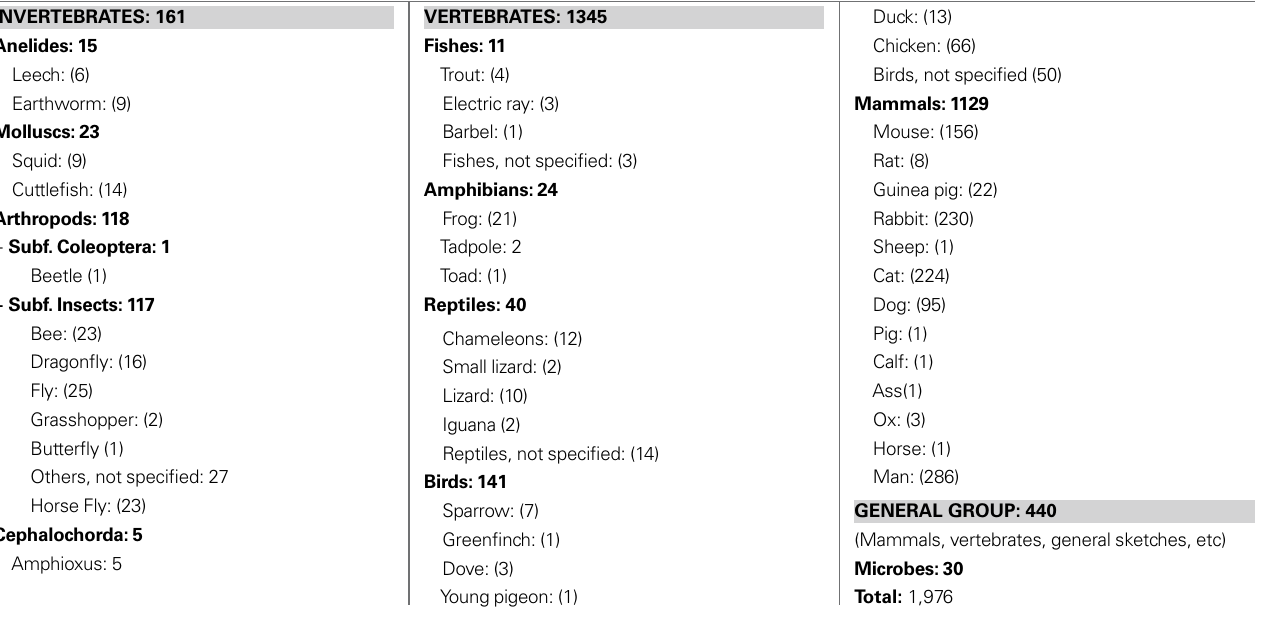
Table 5 | Animals used by S antiago Ramón y Cajal for making his scientifi c